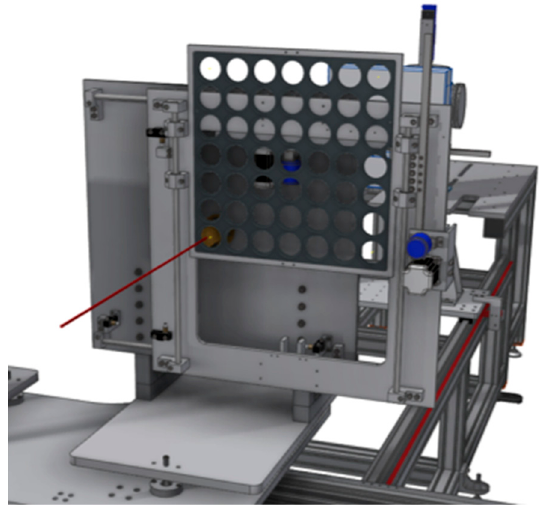
Figure 13. 3D model rendering of the sample irradiation system.